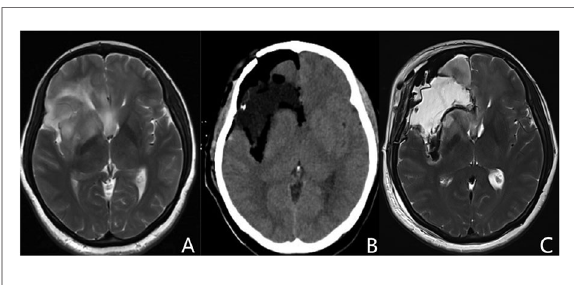
FIGURE 2 Representative images of the basal ganglia outline reappearance. ( A ) Preoperative MRI shows that the basal ganglia is invaded by insular gliomas. ( B,C ) Postoperative CT and MRI T2 imaging demonstrate the arti fi cial pro fi le of the basal ganglia, which is called the basal ganglia outline reappearance. MRI, magnetic resonance imaging; CT, computed